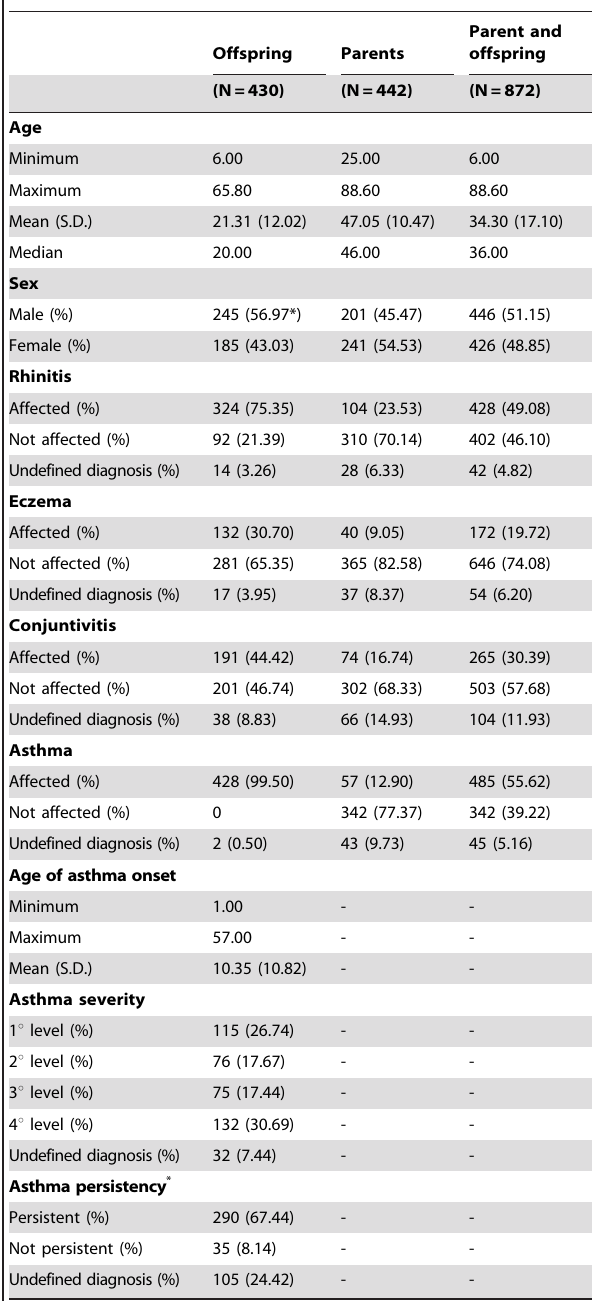
Table 1. The population study